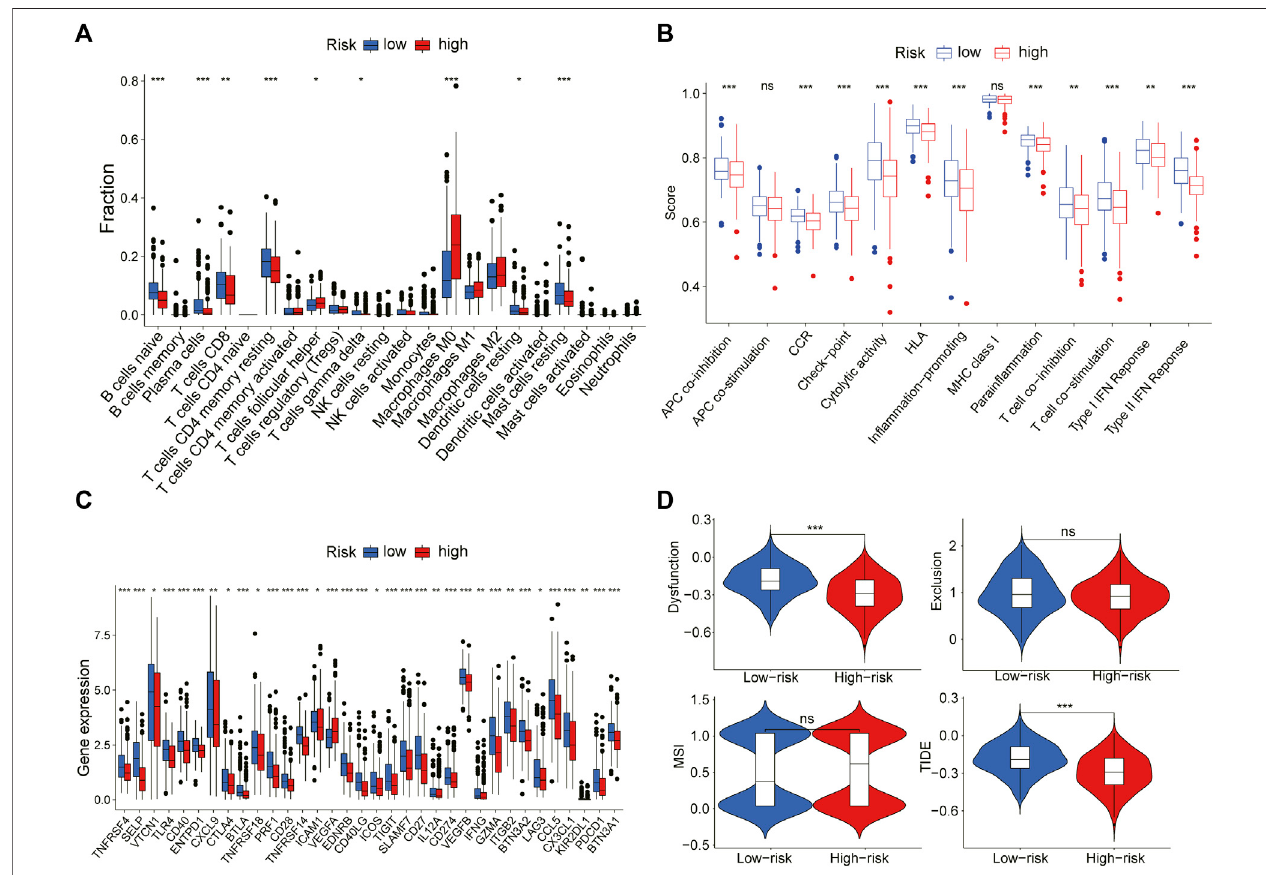
FIGURE9| Therelationbetweenriskscoringmodelandtheimmunemicroenvironment (A) Theplotshowedtheestimatedproportionof22immunecellinthehigh- and low-risk group (B) Box plot of differences in immune related ssGSEA scores between the two groups (C) Box plot of differences in the expression levels of immune relatedincludingimmunecheckpointgenesbetweenthetwogroups (D) Theviolinplotshowedthedifferenceindysfunction,exclusion,MSIandTIDEsignaturebetween two risk groups (Wilcoxon test, * p < 0.05, ** p < 0.01, *** p < 0.001, ns, no signi fi cant difference).